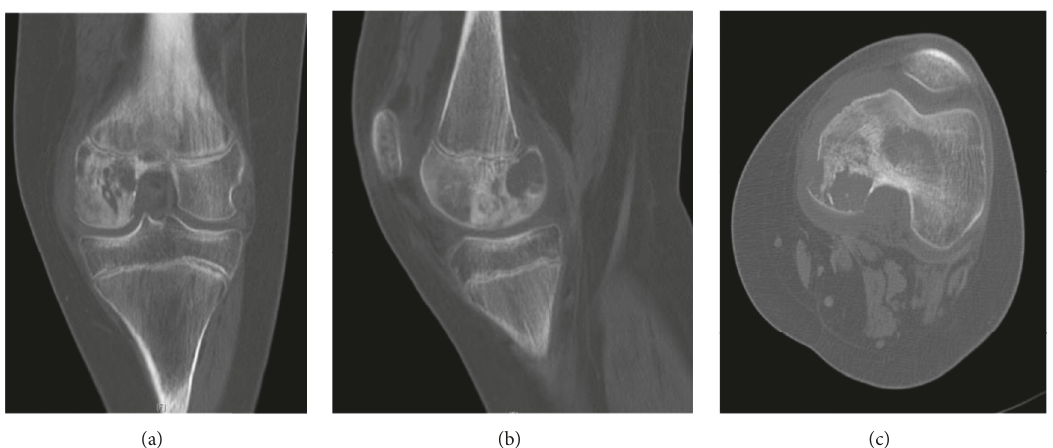
Figure 1: Computed tomography (CT): coronal (a), sagittal (b), and axial views (c) of the left knee, July